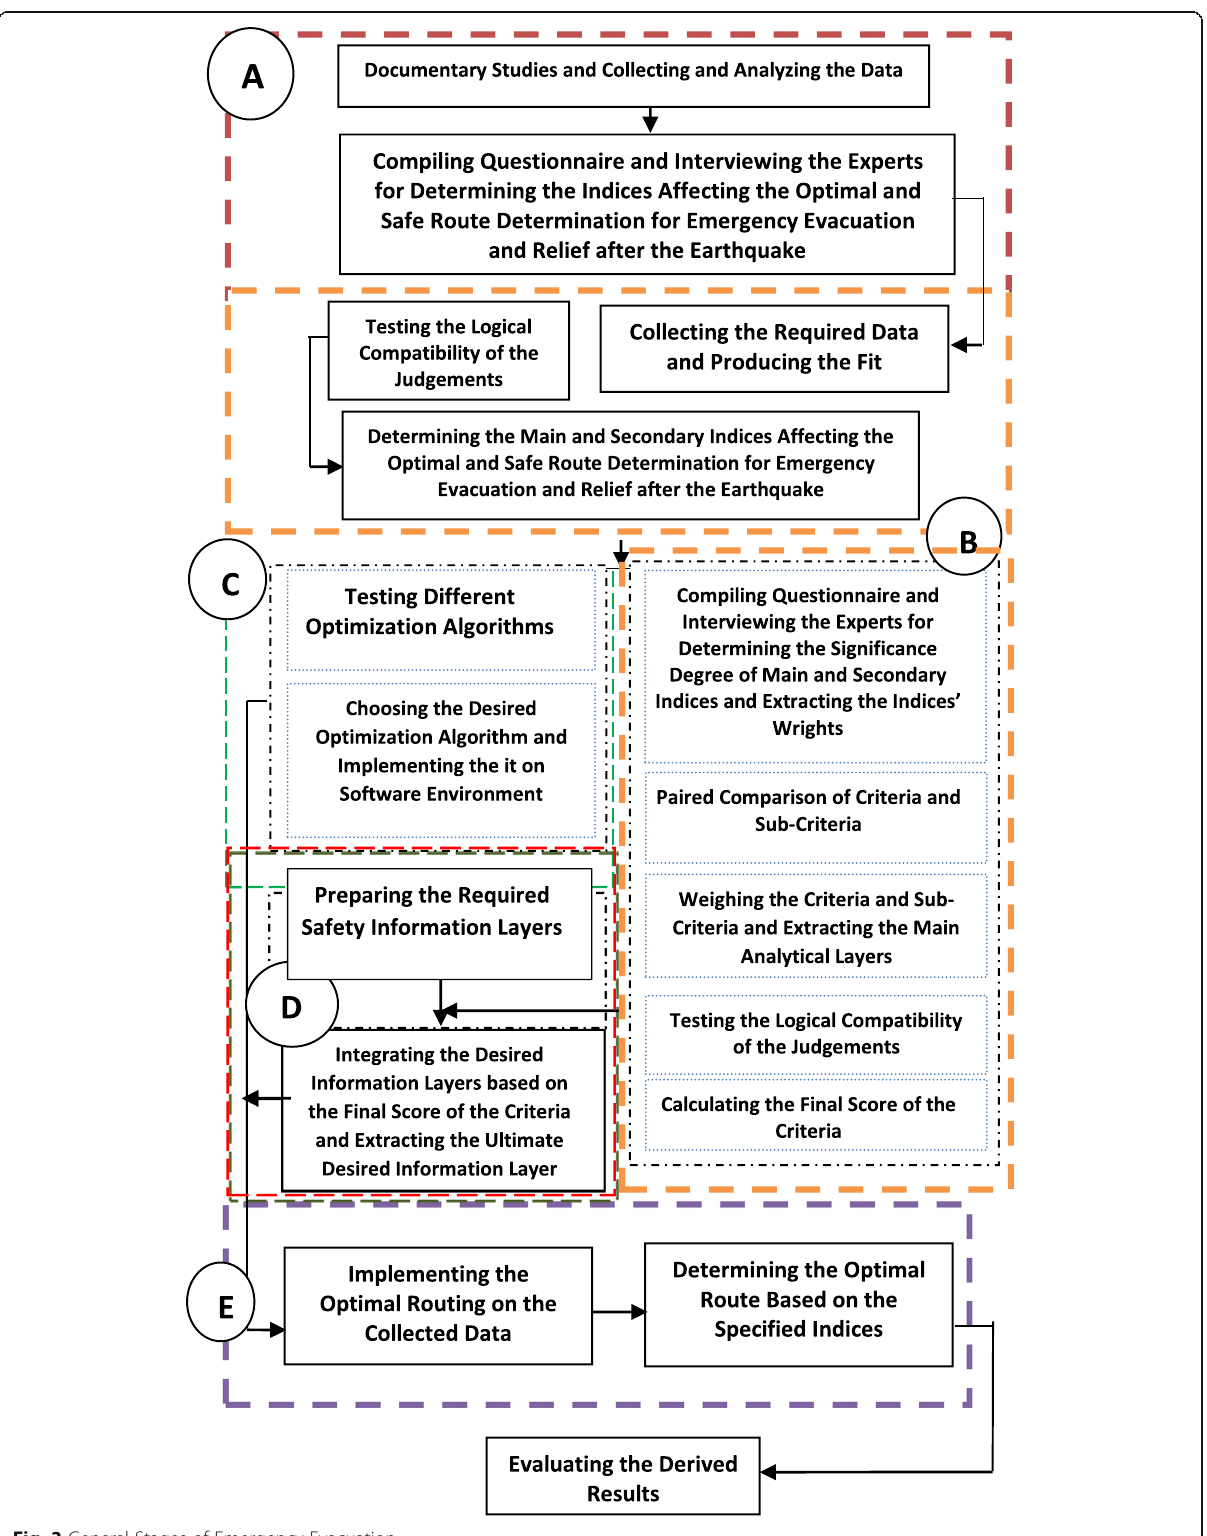
Fig. 3 General Stages of Emergency